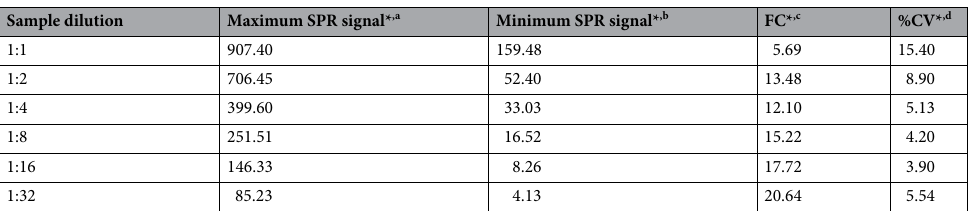
Table 2. Evaluation of different sample dilutions and effect on SPR parameters. *Values in Response Units (RU). a Corresponding to most anti-PnPs IgGs concentrated sample included in the study, as determined by ELISA (429.13 mg/L). b Corresponding to less anti-PnPs IgGs concentrated sample included in the study, as determined by ELISA (8.65 mg/L). c Fold Change between the RU values of the maximum and minimum SPR signal determined for each sample dilution. d Mean of the coefficient of variation between replicates for all samples included in the